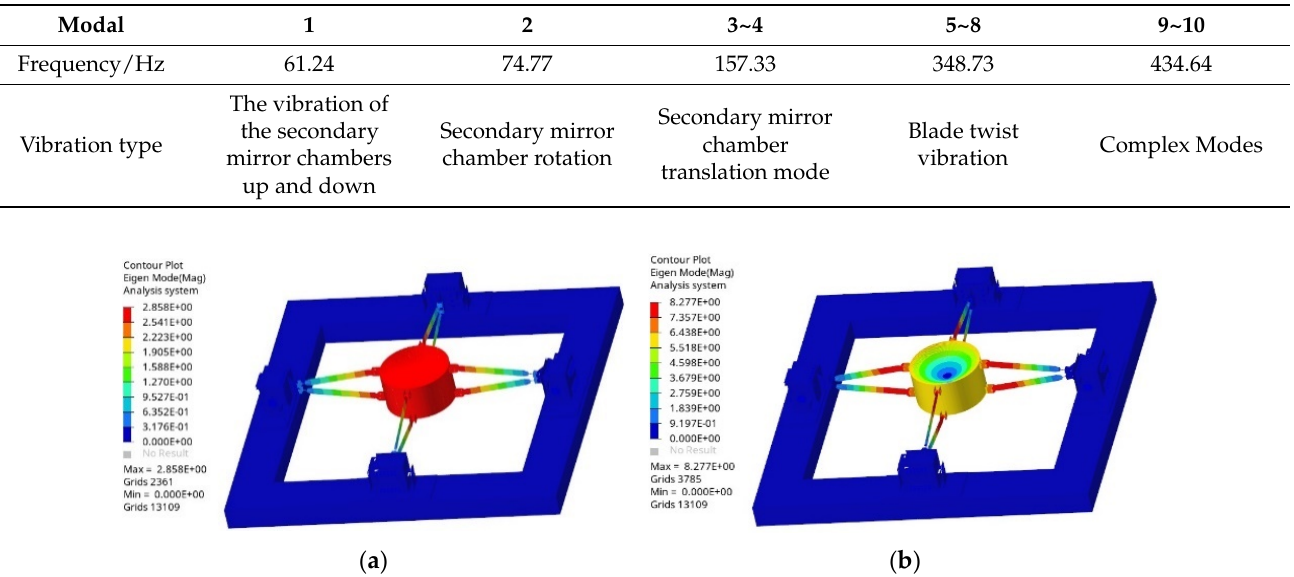
Figure 10. z-directional resolution test.